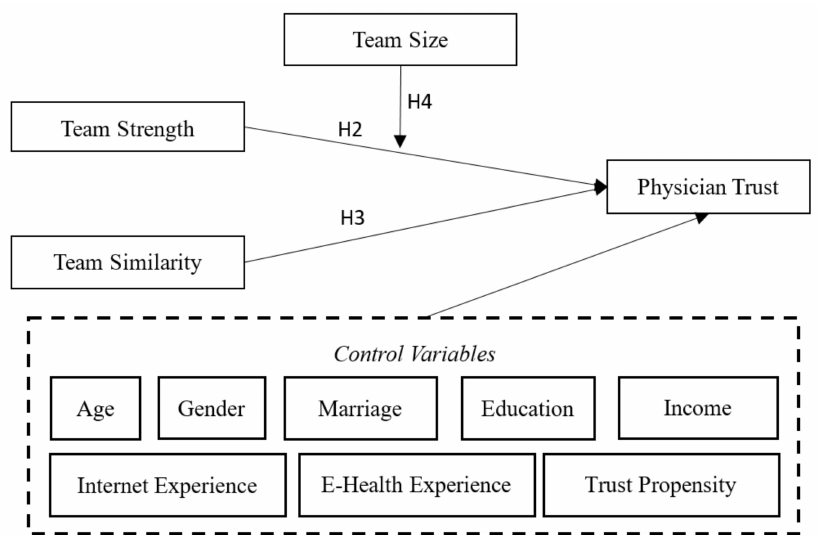
Figure 1. The research